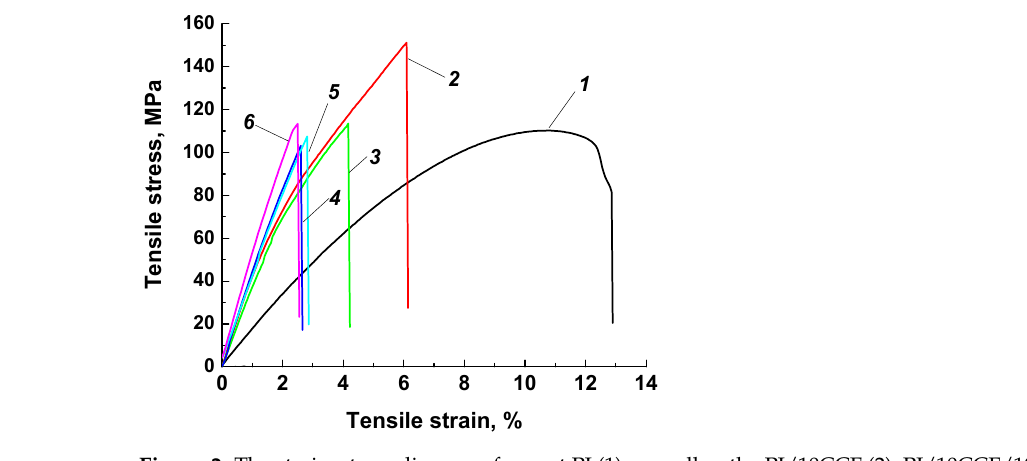
Figure 2. The strain–stress diagrams for neat PI (1), as well as the PI/10CCF (2), PI/10CCF/10PTFE (3), PI/10CCF/10Gr (4), PI/10CCF/10MoS 2 (5) and PI/10CCF/23MoS 2 (6) composites. Table 2. The physical and mechanical properties of the PI-based composites.